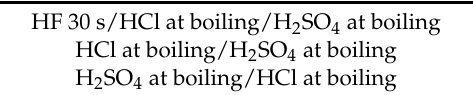
Table 3. The etching parameters for multiple types of